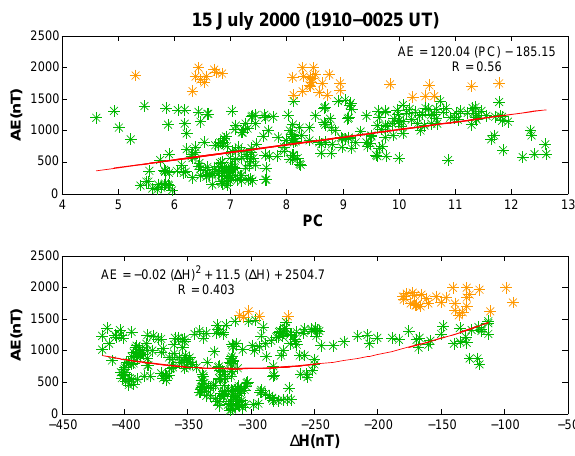
Fig. 13. For “ T 2” duration (19:10–00:25 UT) for the 15 July 2000 storm event, correlations between polar cap ( PC ) index and auro- ral electrojet ( AE ) index are depicted in upper panel. Lower panel shows correlations between horizontal component of geomagnetic field at Alibag ( 1H ABG ) and AE index. Green colour symbols rep- resent correlations for AE values lying within 1500 nT and orange colour depicts correlations for AE values more than 1500nT.